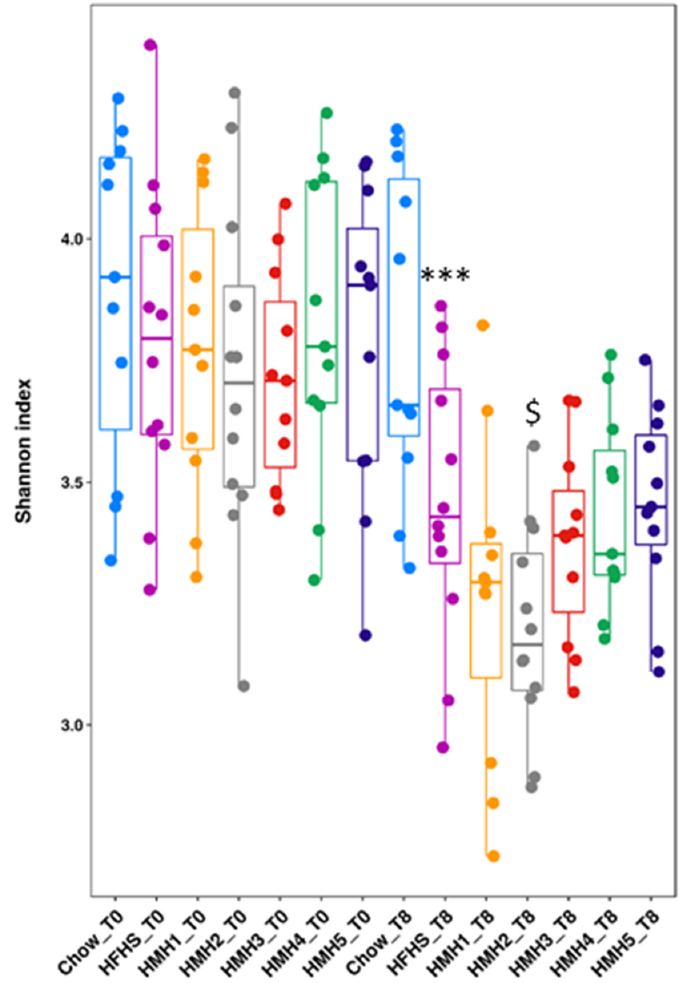
Figure 5. Shannon diversity index calculated at week 0 and 8 for all groups. *** p < 0.05 Chow vs. HFHS, $ p < 0.05 HFHS vs. HFHS, $ p < 0.05 HFHS vs. HMH2.